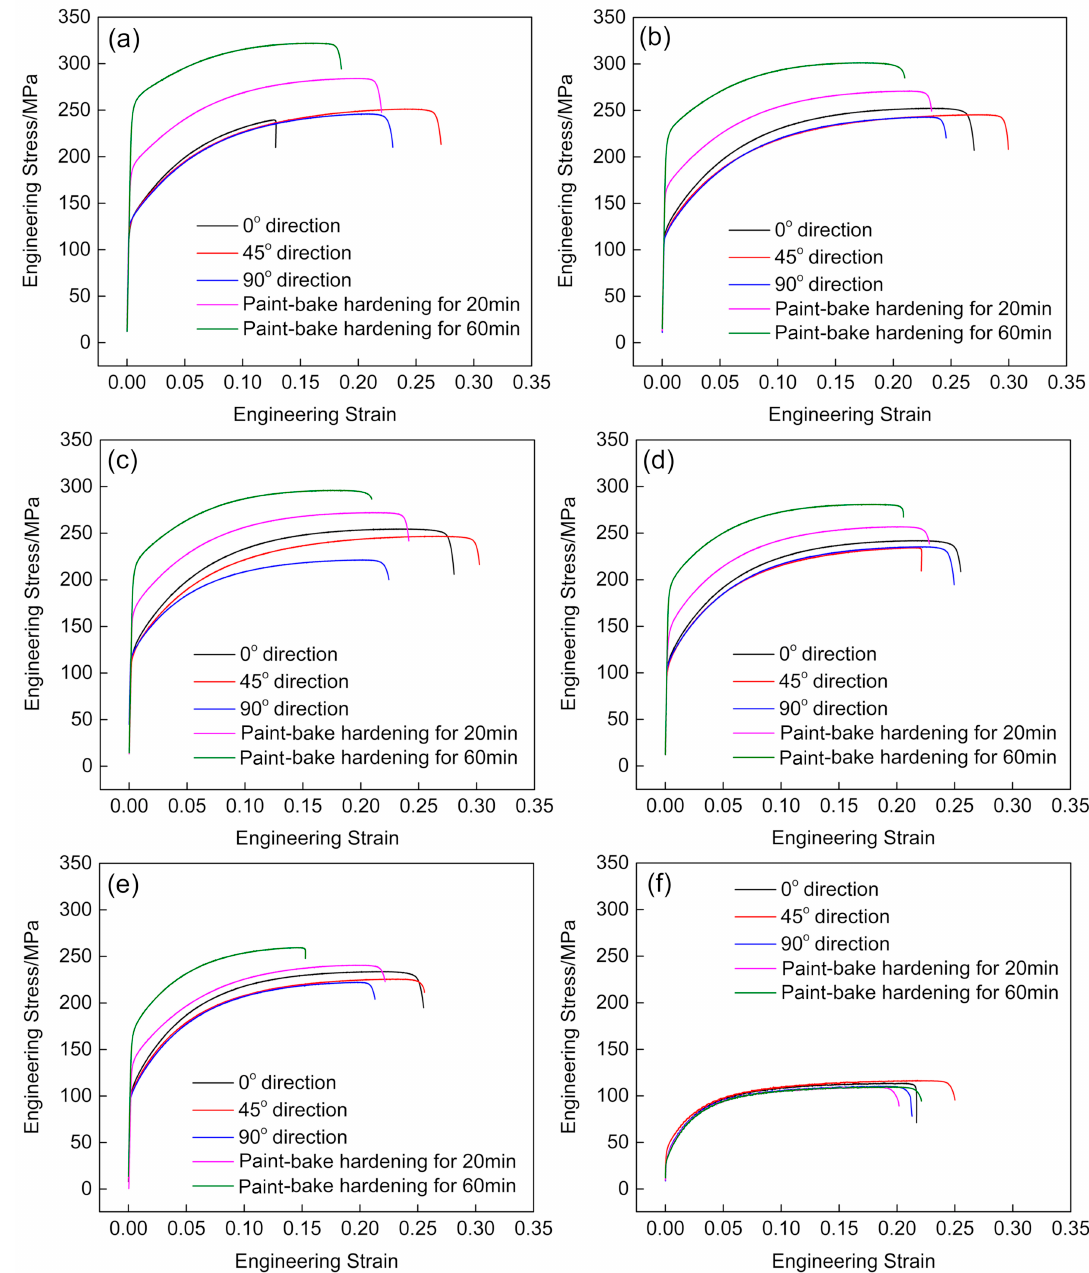
Figure 6. Engineering stress–strain curves of samples with different quenching rates after pre-aging treatment: ( a ) 58.9 °C/s, ( b ) 14.0 °C/s, ( c ) 7.0 °C/s, ( d ) 2.8 °C/s, ( e ) 1.6 °C/s, and ( f ) 0.01 °C/s.